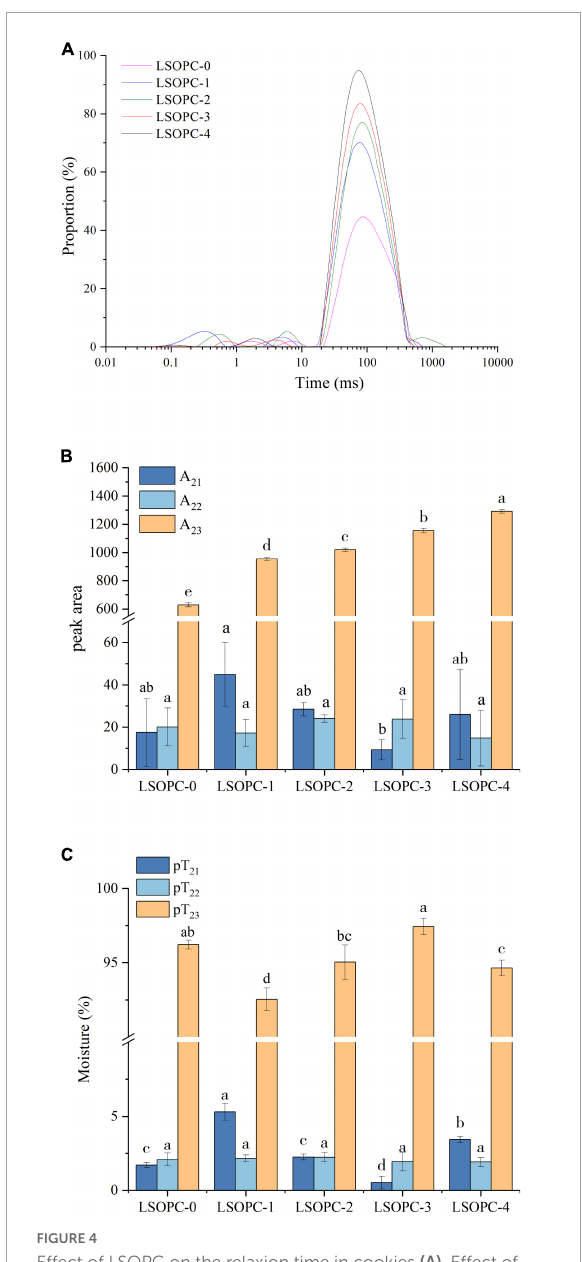
FIGURE4 Effect of LSOPC on the relaxion time in cookies (A) . Effect of LSOPC on the peak area of different water in cookies (B) . Effect of LSOPC on the content of different water in cookies (C) . Significant differences ( p < 0.05) of data values are indicated by different